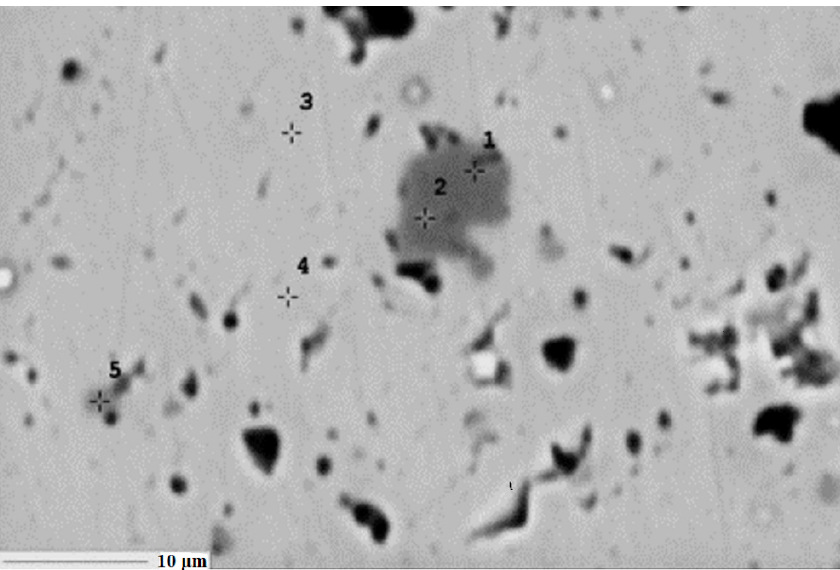
Figure 13. BSE image of sample S2, limestone of the Dziewkowice Unit taken in the